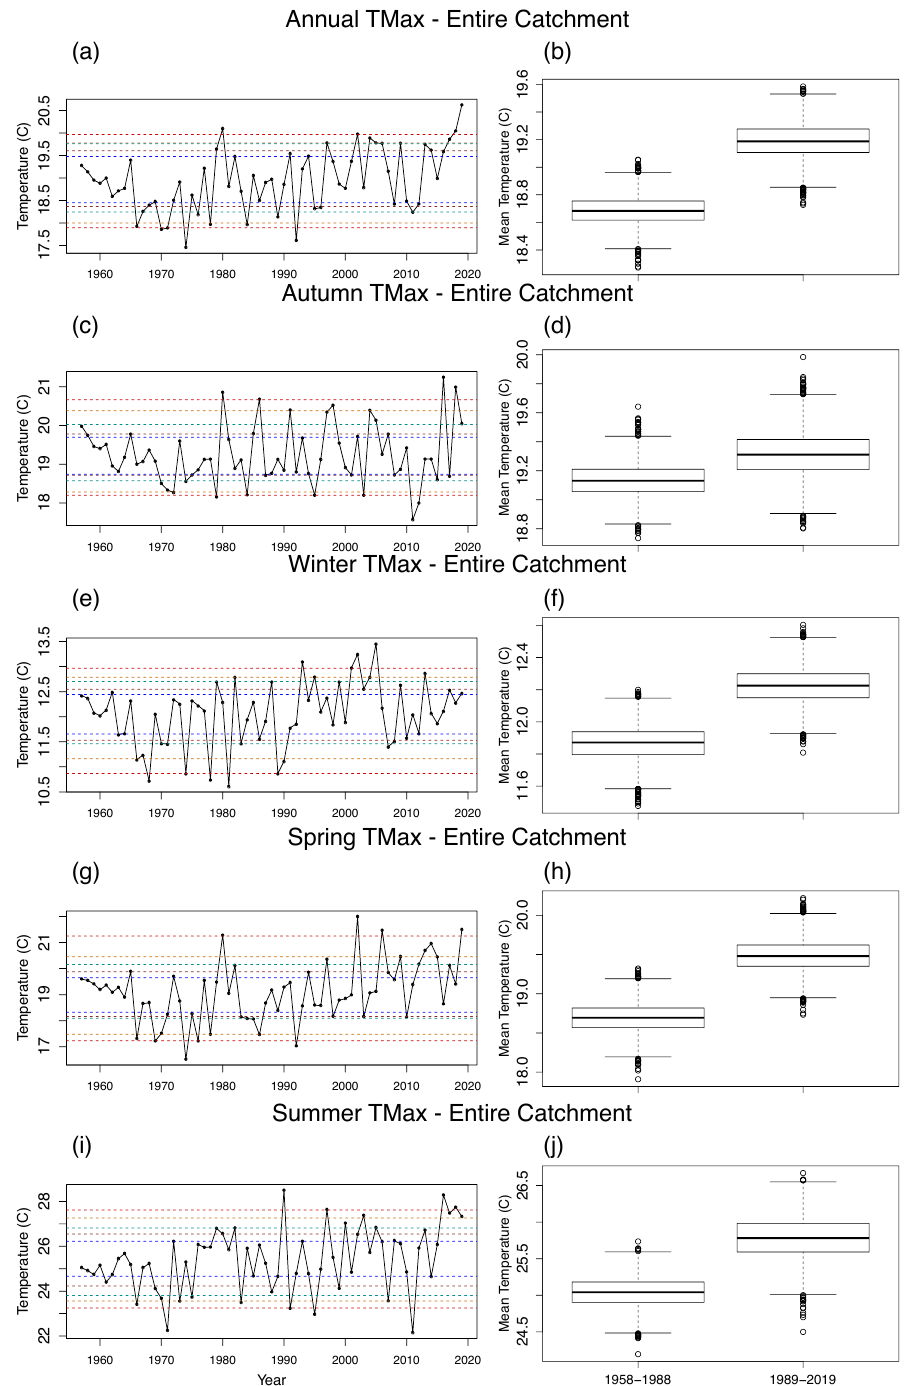
Figure 4. (left panels, ( a , c , e , g , i )) Annual mean TMax time series across the SCA; and (right panels, ( b , d , f , h , j )) box plots of the bootstrapped mean TMax over 31-year periods for the SCA, as in Figure 3 but for mean